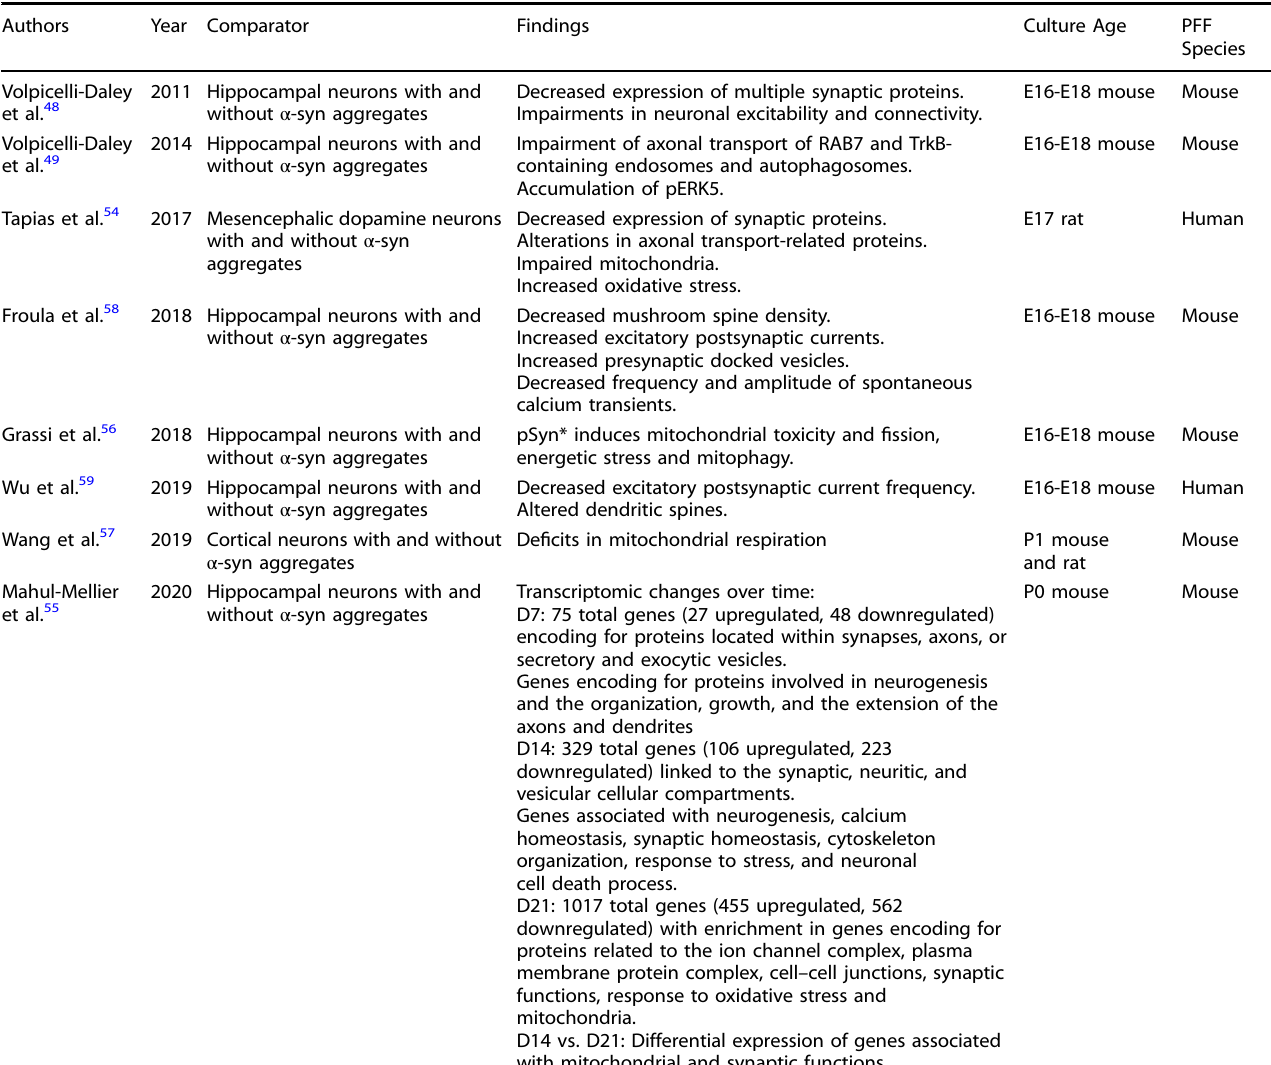
Table 2. Synucleinopathy-associated pathogenesis in PFF culture